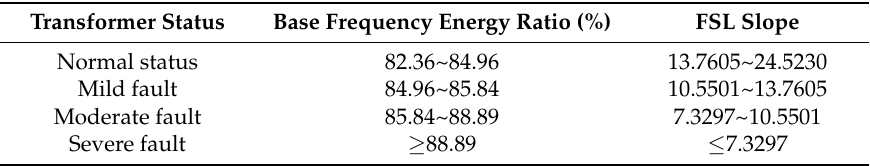
Table 3. Transformer winding short circuit fault degree